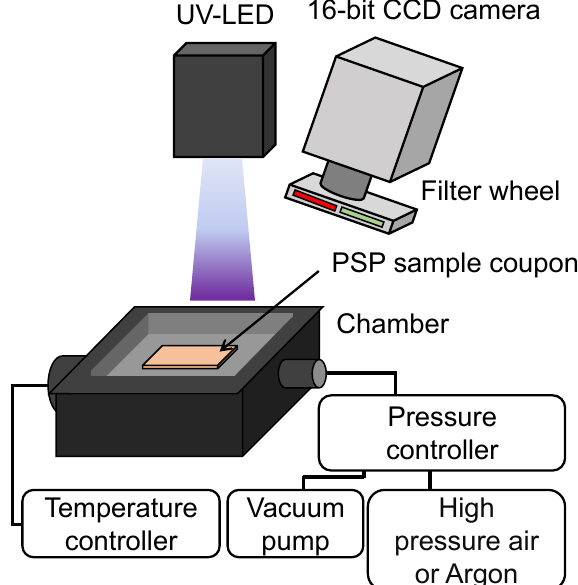
Figure 4. Schematic of the PSP calibration